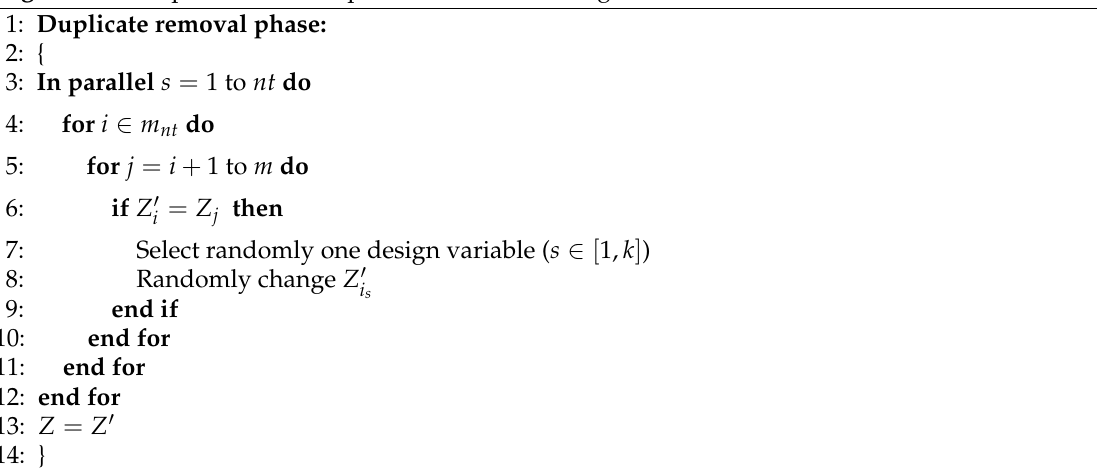
Algorithm 6 Duplicate removal phase of SPG_TLBO